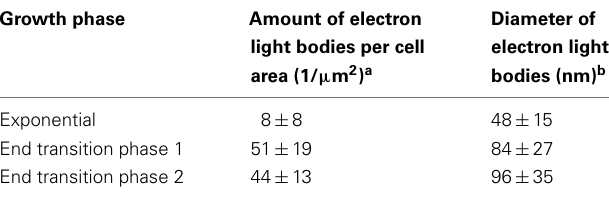
Table 1 |Amount and diameter of electron light bodies per cell in different growth phases as observed with transmission electron microscopy of chemically fixed cells.